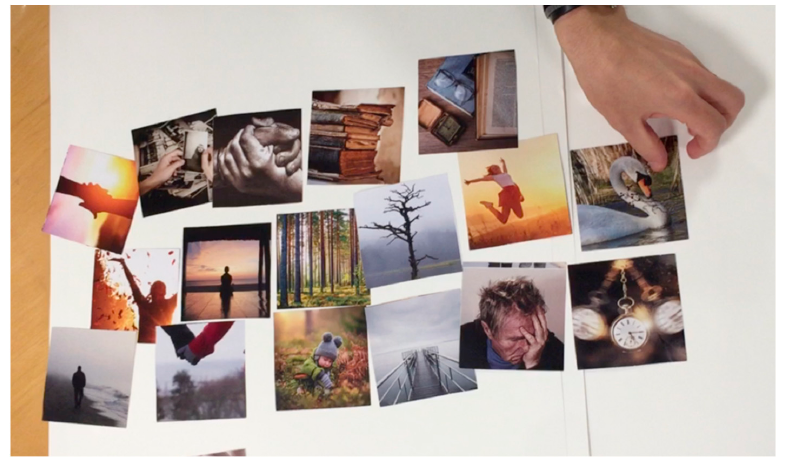
Figure 3. Example of the complication cards presented to the Age Workshop participants.